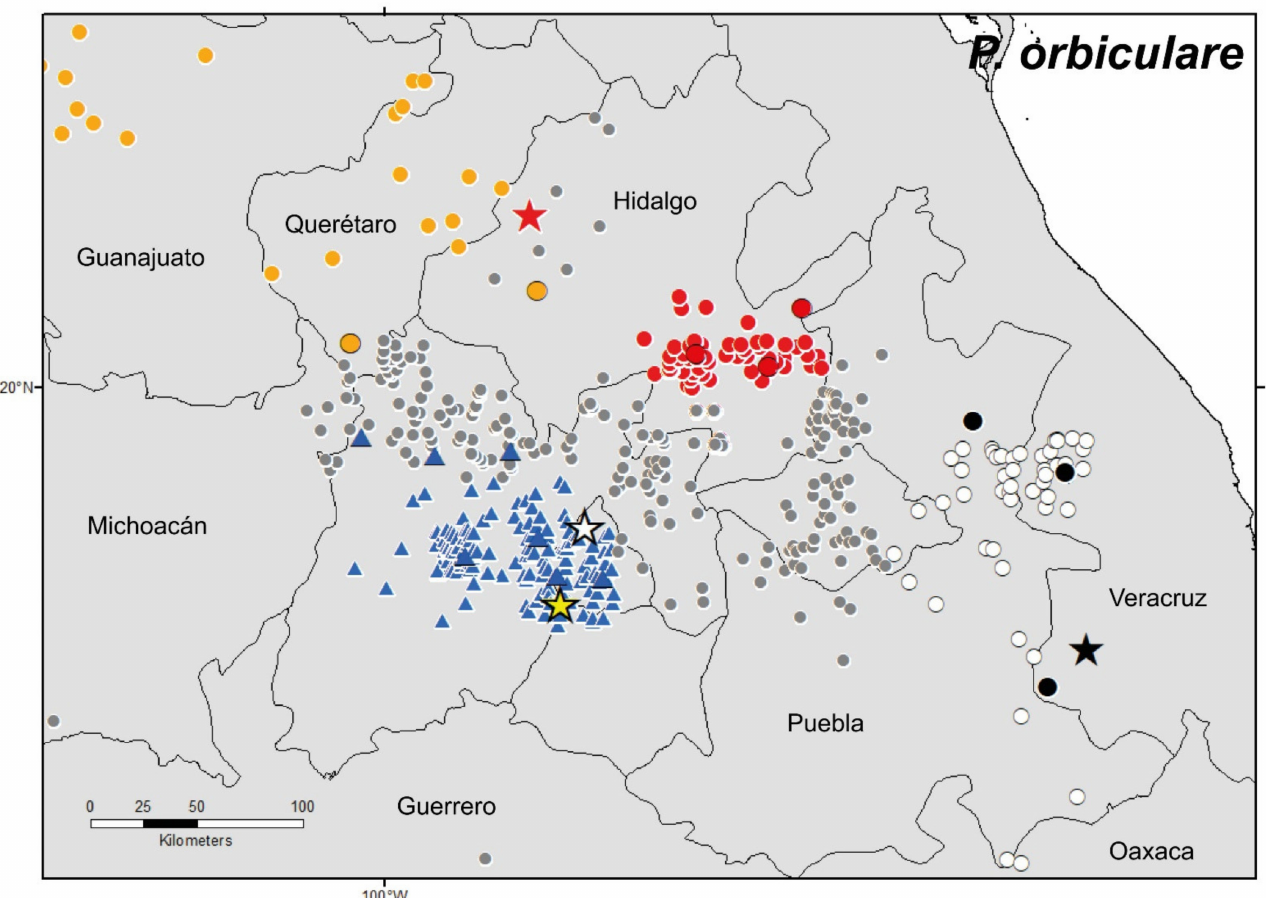
Figure 15. Map showing distributional records of Phrynosoma orbiculare in the southern portion of its distributional range. Symbols as in Figure